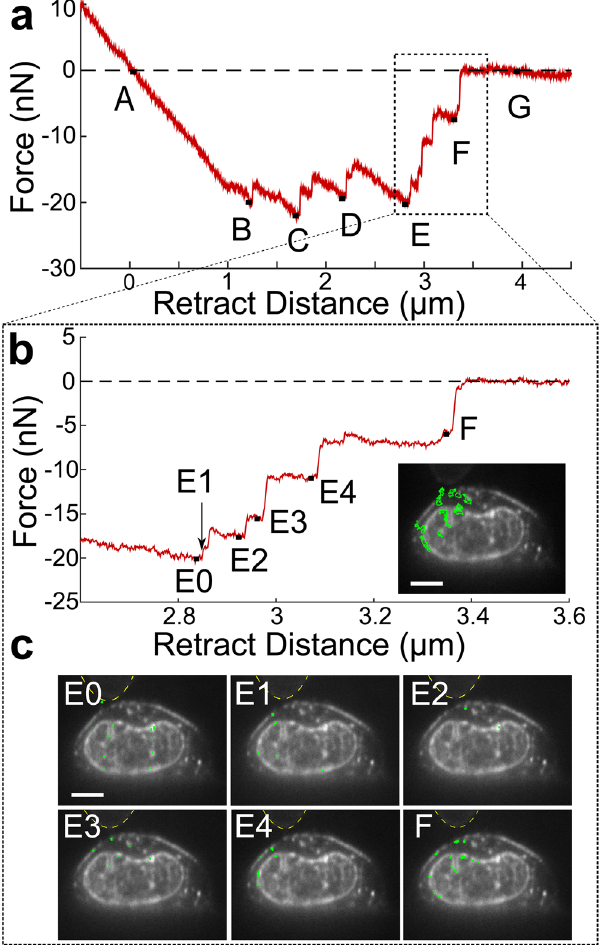
Figure 5. Membrane and nuclear displacements observed in response to force-rupture events between the AFM-tip and cell membrane. ( a ) Retraction portion of force-indentation curve with important points (A-G) identified. A, the point of zero force application to the cell, B-F, force-rupture peaks, and G, after bead releases from cell. ( b ) A closer examination of peaks E and F with sub-peaks of the E rupture event identified. No point is shown for E1 because this is the frame immediately following Peak E0. Inset indicates regions where displacement is measured between points E and F highlighted in green. These regions were determined through difference imaging using frames taken at E and F. ( c ) Regions of cell displacements determined through difference imaging highlighted in green for the sub-peaks indicated in ( b ). Yellow dashed lines indicate outline of AFM mounted bead. Scale bars = 5